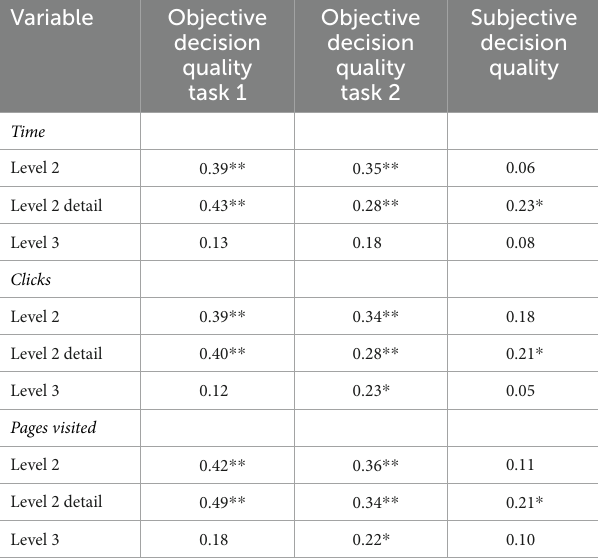
TABLE 3 Pearson-correlations between verification intensity indicators and objective and subjective decision